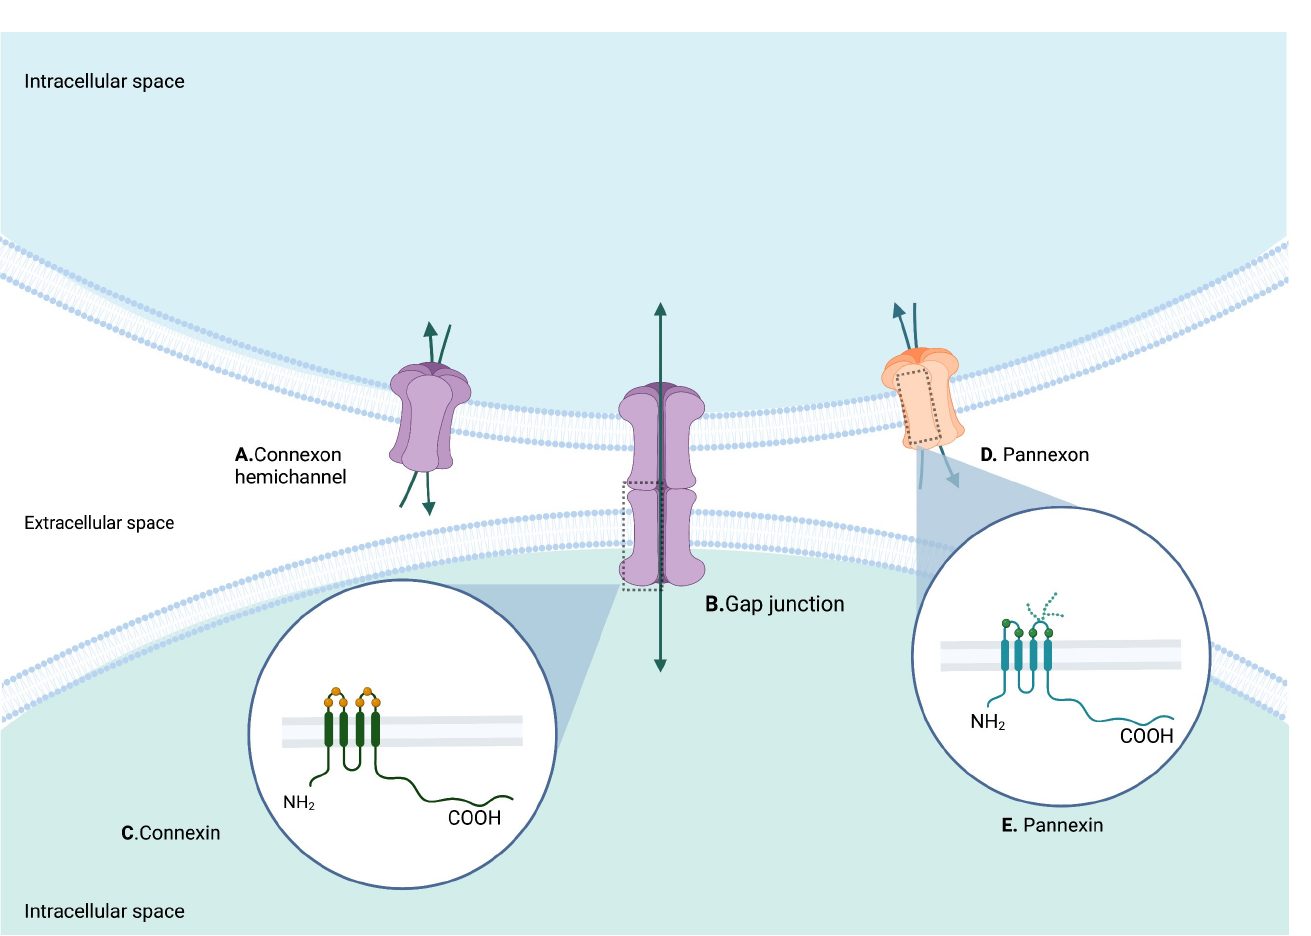
ease 1. Cxs and Panxs are also involved in the pathogenesis of adult neurological diseases, namely neurodegenerative diseases, such as Alzheimer’s and Parkinson’s disease, multi- ple sclerosis, peripheral neuropathies, and most recently in ischemia [27,28].